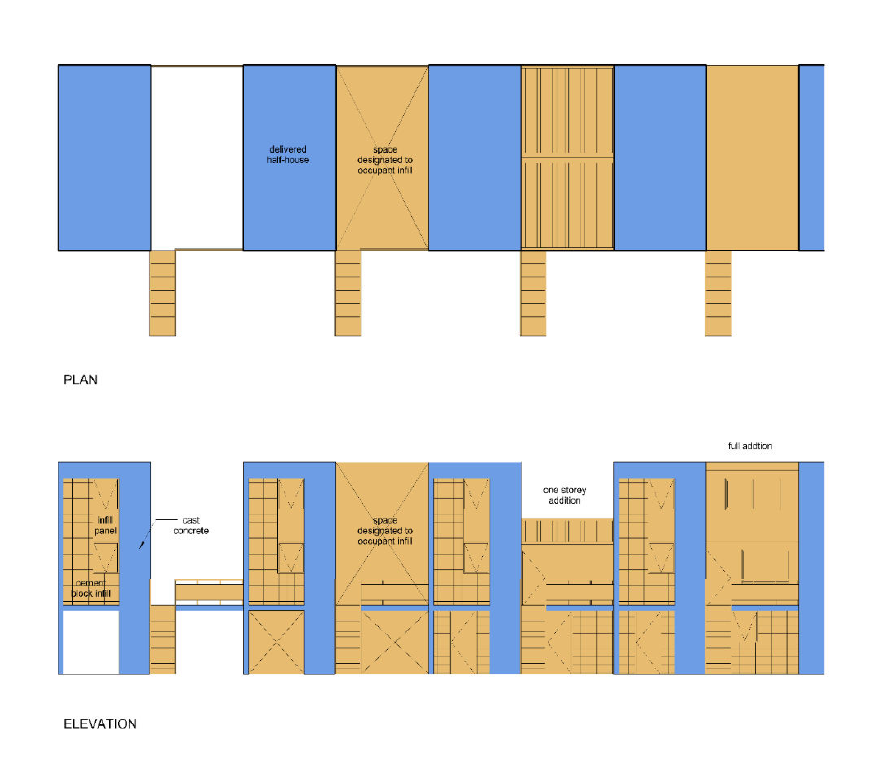
Figure 3: Plan and elevation of Half a House illustrating the delivered structure in blue and the intended additions and adaptations in orange. By author, 2022. Along with the shared walls between the units, these elements form an indicative envelope and infrastructure that the occupant can fill in to expand their house. The occupant can immediately move into the delivered structure and in time develop the secondary structure as they need.